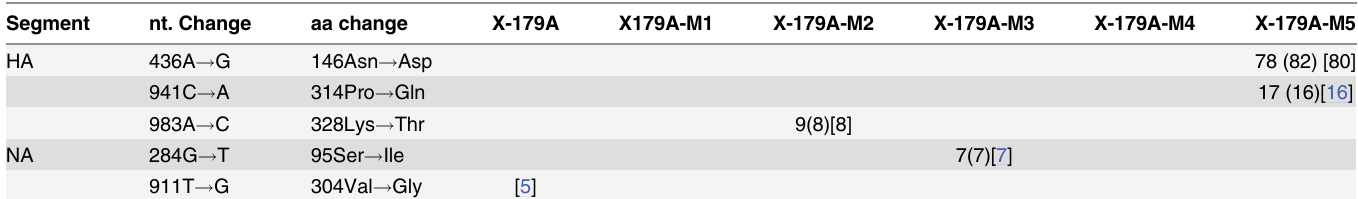
Table 6. Mutation percentages ( (cid:3) 5%) emerged in HA and NA of X-179A viruses passaged in eggs. Notes: The percentages obtained from RNA library followed by HiSeq sequencing are presented without parentheses or brackets. The percentages obtained from RNA library followed by MiSeq sequencing are presented in parentheses. The percentages obtained from DNA library followed by HiSeq sequencing are presented in brackets. These mutation percent- ages were calculated per comparison with the corresponding expanded progenitor. (See accession numbers in Materials and Methods.) aa: Amino-acid, nt: Nucleotide.